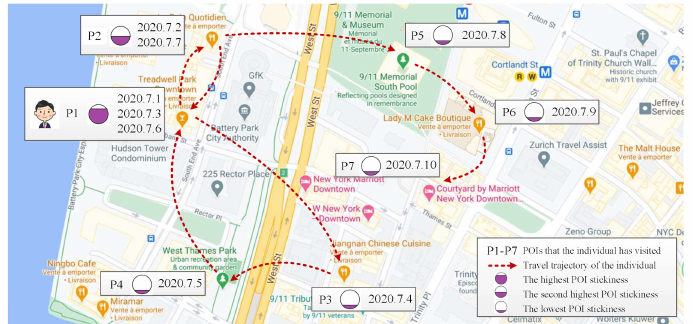
Figure 3. A toy example of an individual’s travel trajectory between 1 July 2020 and 9 July 2020. Based on the memory-based preference-attenuation mechanism, with respect to the current time (e.g., 1 August 2020), the value of the check-in at P7 is the highest among all the POIs. However, the POI-stickiness value of the individual at P7 is the lowest. In other words, the individual will not repeatedly visit P7 and has a lower degree of preference for P7. Thus, P7 cannot dominate the individual’s travel behaviors. Considering the influence of POI stickiness, the individual has the highest stickiness and visiting frequency at P1, the second-highest stickiness and visiting frequency at P2, and the lowest stickiness and visiting frequency at other POIs. Obviously, P1 plays the most significant role in the individual’s travel decisions, followed by P2, and other POIs have a relatively low